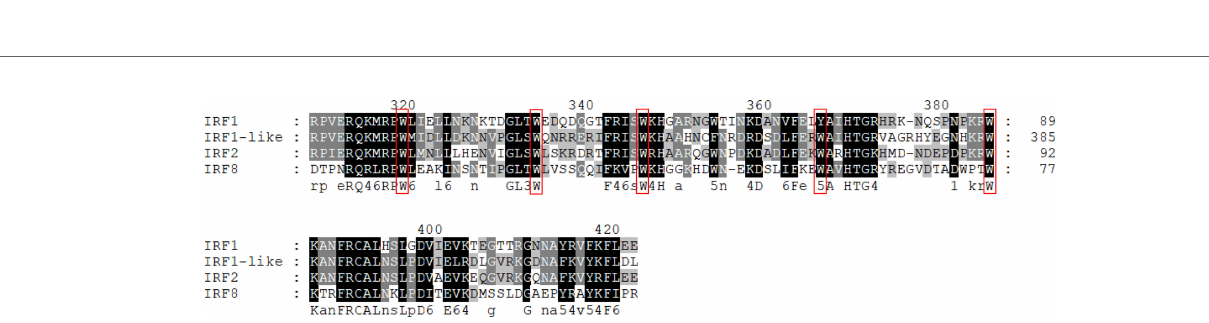
FIGURE 2 | Protein structure of the CfIRF genes. The blue boxes indicate the DBD domain. The orange boxes indicate the IAD domain. The red boxes indicate the ZnF_C2H2 domain.